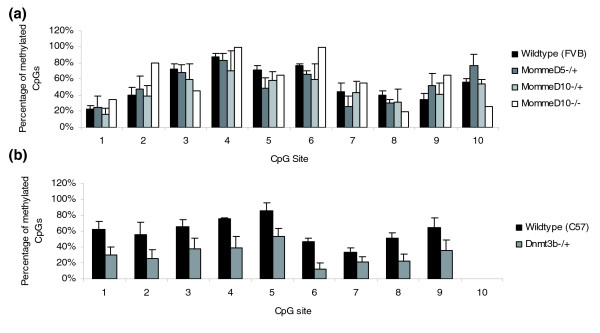
Bisulfite analysis of the HS-40 enhancer element. (a) DNA was extracted from the spleen of 4-week-old wild-type (FVB/NJ; three mice), MommeD5-/+ (three mice), MommeD10-/+ (three mice) mice and from the tail of MommeD10-/- mice (two mice). After bisulfite sequencing, the percentage of CpG methylation at each CpG site in the cloned region was analyzed, and averaged across individuals of the same genotype. None are significantly different from the wild-type mouse. Error bars represent SEM. (b) DNA was extracted from the tail of 4-week-old wild-type (C57BL/6; four mice) and Dnmt3b+/- (four mice) mice. After bisulfite sequencing, the percentage of CpG methylation at each CpG site in the cloned region was analyzed, and averaged across individuals of the same genotype. The Dnmt3b+/- mice have significantly (p < 0.001) less methylation than the wild-type mice. Error bars represent SEM.